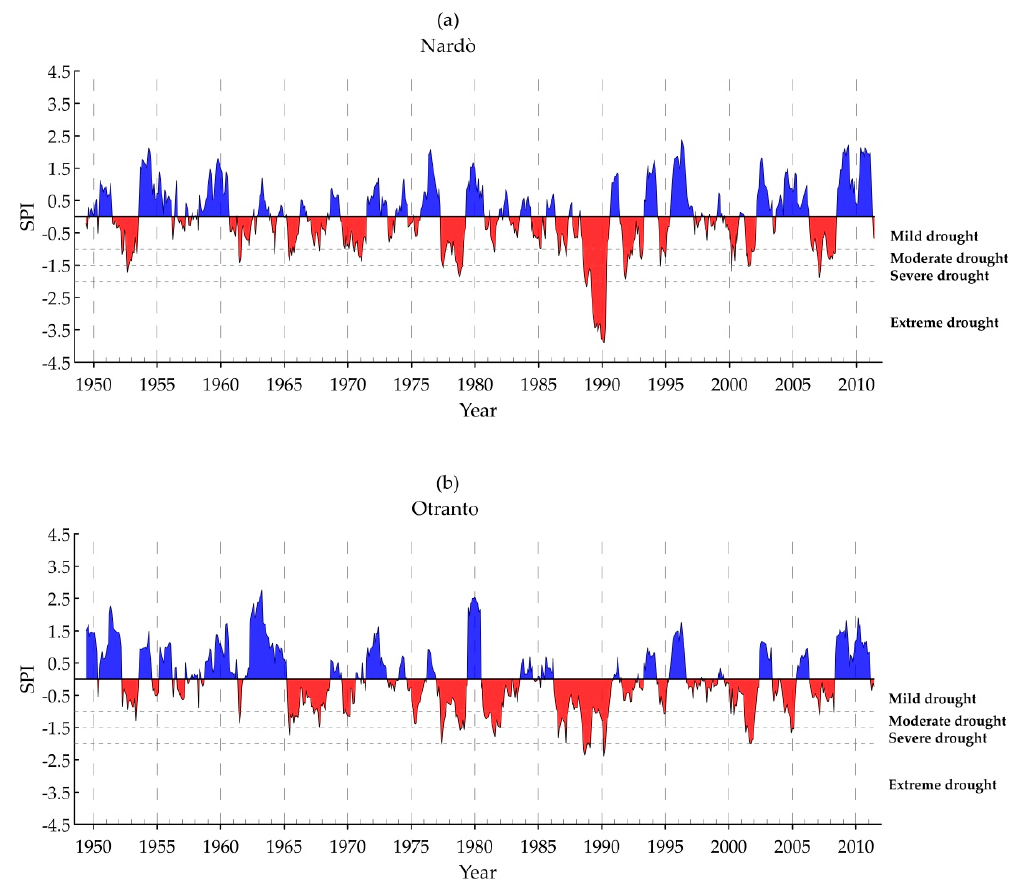
Table 5. Mean values of annual rainfall (mm).